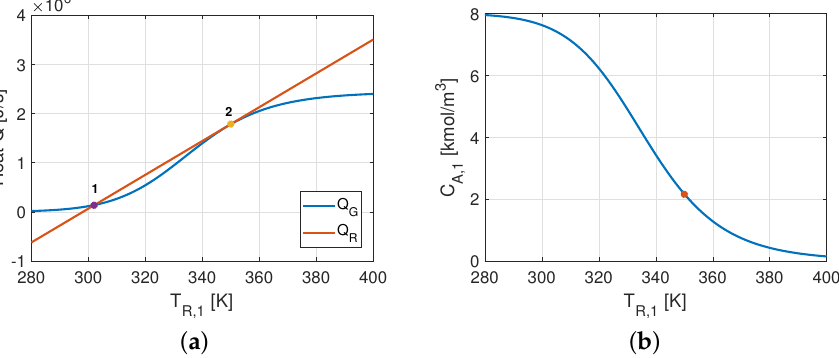
Figure 6. Van Heerden diagram and conversion condition. ( a ) Heat removal vs. heat generated (CSTR 1); ( b ) Concentration of C A (CSTR